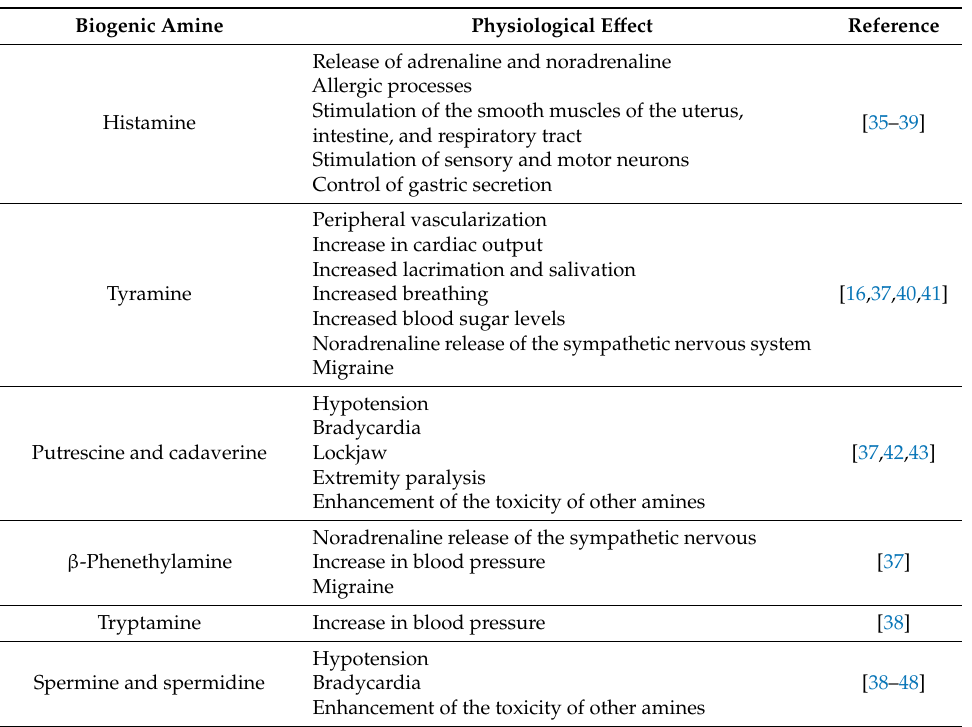
Table 1. Physiological e ff ect of biogenic amines.